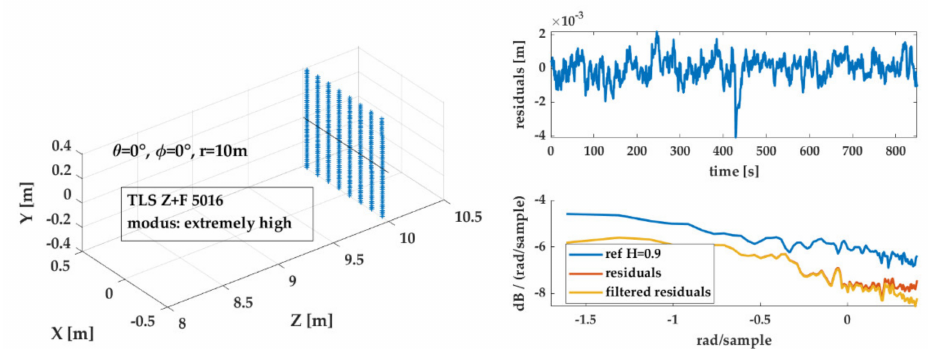
Figure 10. ( left ): The schematic scanning configuration: no tilt and a distance of 10 m to the center of the coordinate system. Right, top: residuals of the B-spline approximation for the plane under consideration. ( right,bottom ): The corresponding PSD. The blue line is a reference fGn with H ref = 0.9, the red line corresponds to the residuals and the yellow one to the filtered residuals with log